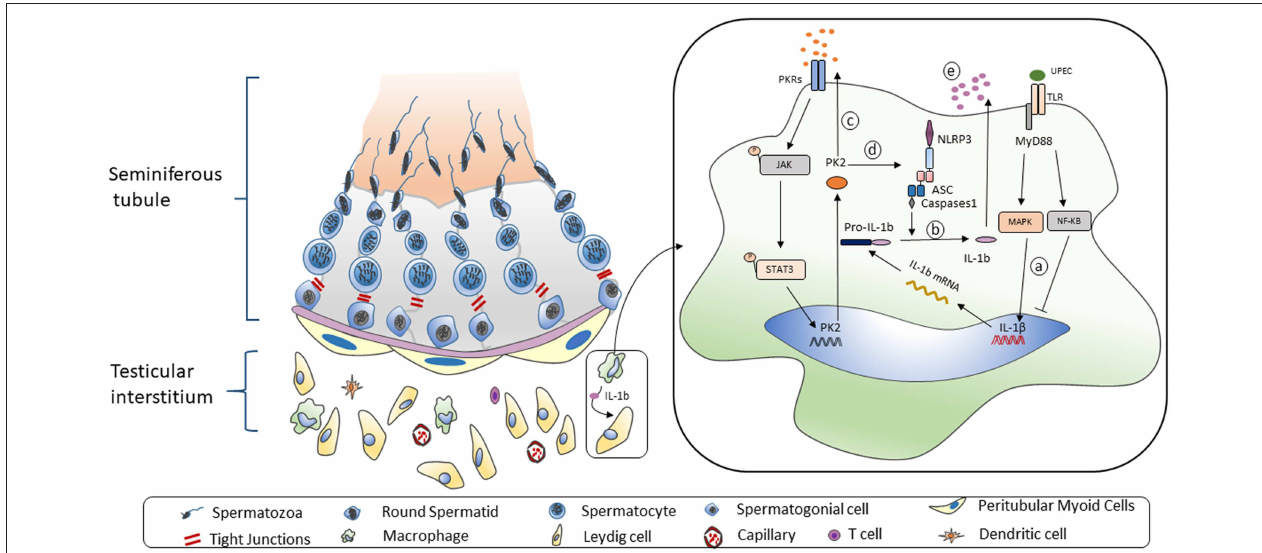
FIGURE 7 | Working model of UPEC-induced NLRP3 inflammasome activation in TM. Left: The mammalian testis is compartmentalized to two main parts. The seminiferous tubes are composed of various developing germ cells surrounded by Sertoli cells, while the testicular interstitial space consists of androgen-producing Leydig cells, and multiple types of immune cells. A significant proportion of macrophages is structurally coupled with Leydig cells with anatomical and functional relation. Right: When TM challenged by UPEC a. Activation of MAPK pathway but not NF- κ B pathway induces the pro-IL-1 β synthesis. b. The NLRP3 inflammasome pathway is triggered to secret IL-1 β . c. Biological function of TM-derived PK2 is augmented and sustained via an autocrine and paracrine manner. d. PK2 promotes NLRP3 expression and boost inflammasome pathway activation to secret IL-1 β . e. IL-1 β is released to testicular interstitium from TM to suppress the testosterone